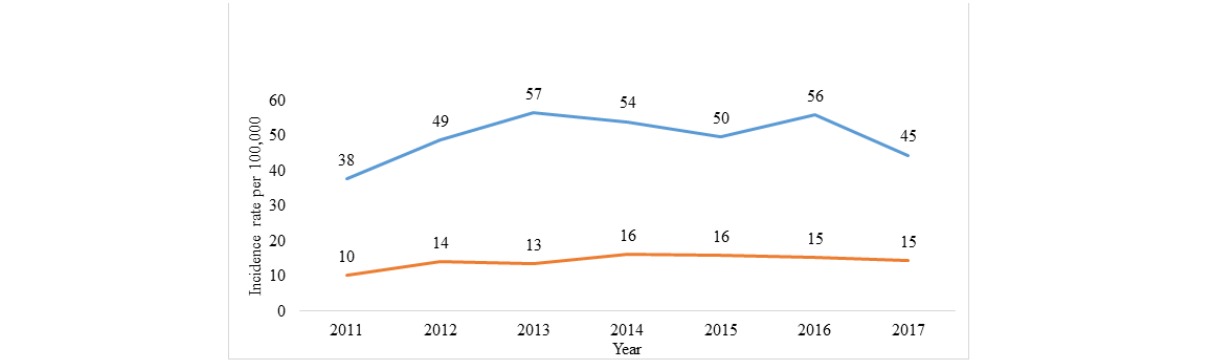
Figure 2. Incidence rate of animal bites and exposed cases in Yemen from 2011 to 2017. Blue line: animal bites/100,000; orange line: exposed cases/100,000.